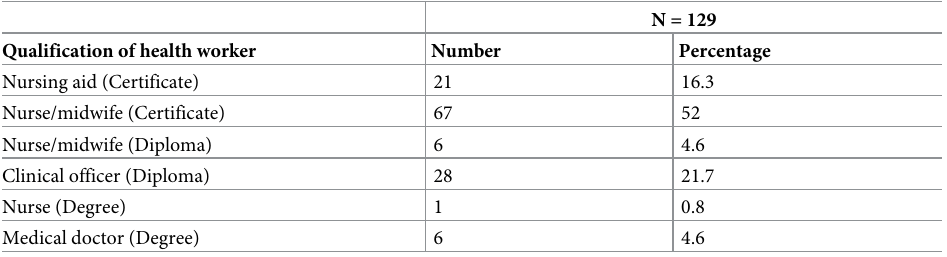
Table 2. Qualification of the health workers assessed for knowledge in LLPHFs in Mbarara